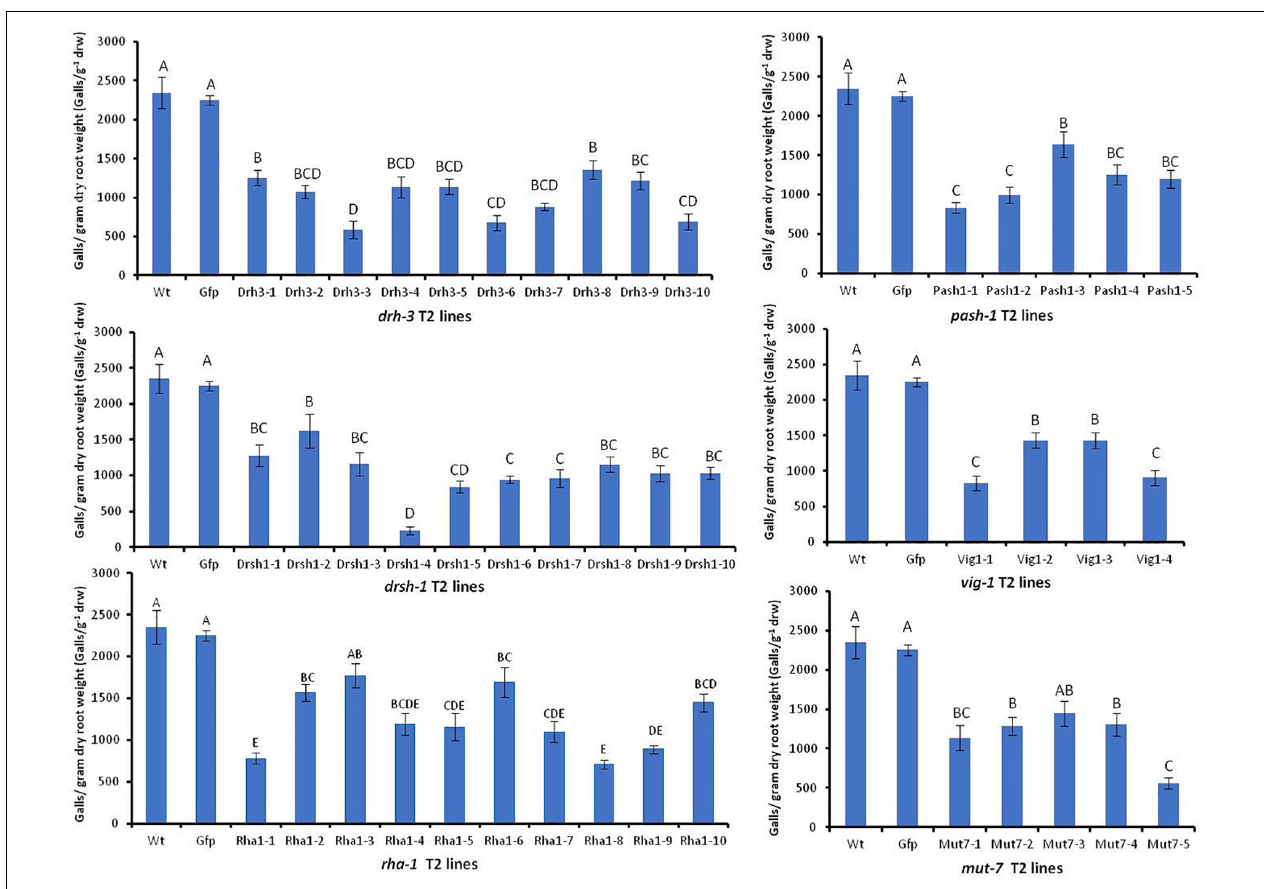
FIGURE 5 | Mean number of galls per gram of dry root weight induced by M. incognita J2s on wild-type and transgenic Arabidopsis expressing hairpins of six M. incognita genes and the gfp gene. Bars represent mean number of galls per gram dry root weight ( n = 9–16) ± standard error. Significant differences ( p < 0.05 ) are indicated by different